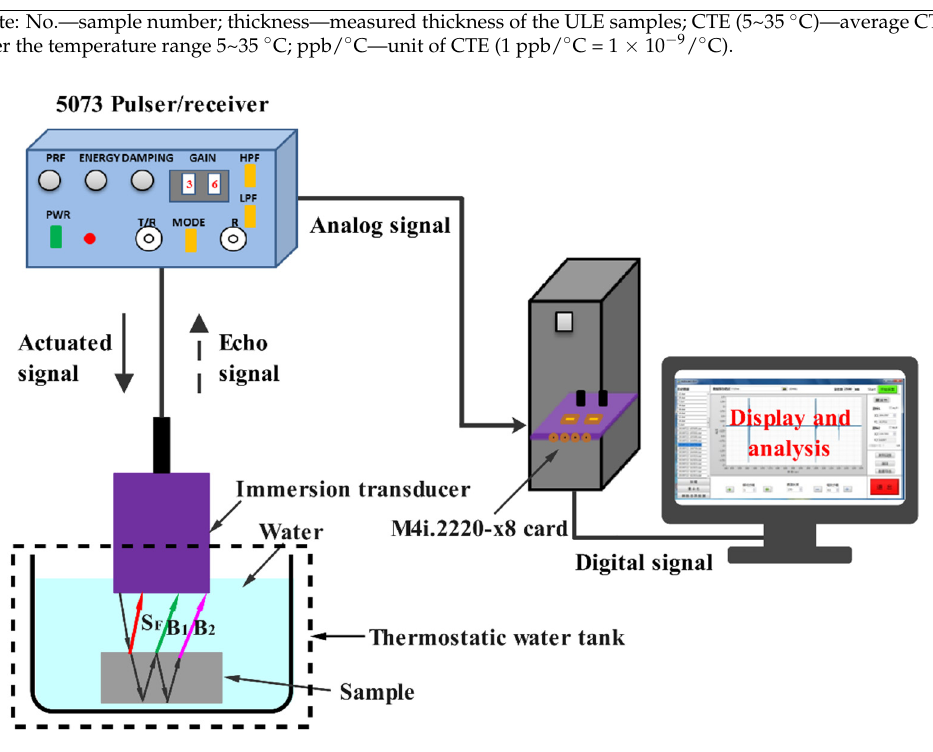
Figure 4. Schematic diagram of the experimental system for measuring ultrasonic velocity.